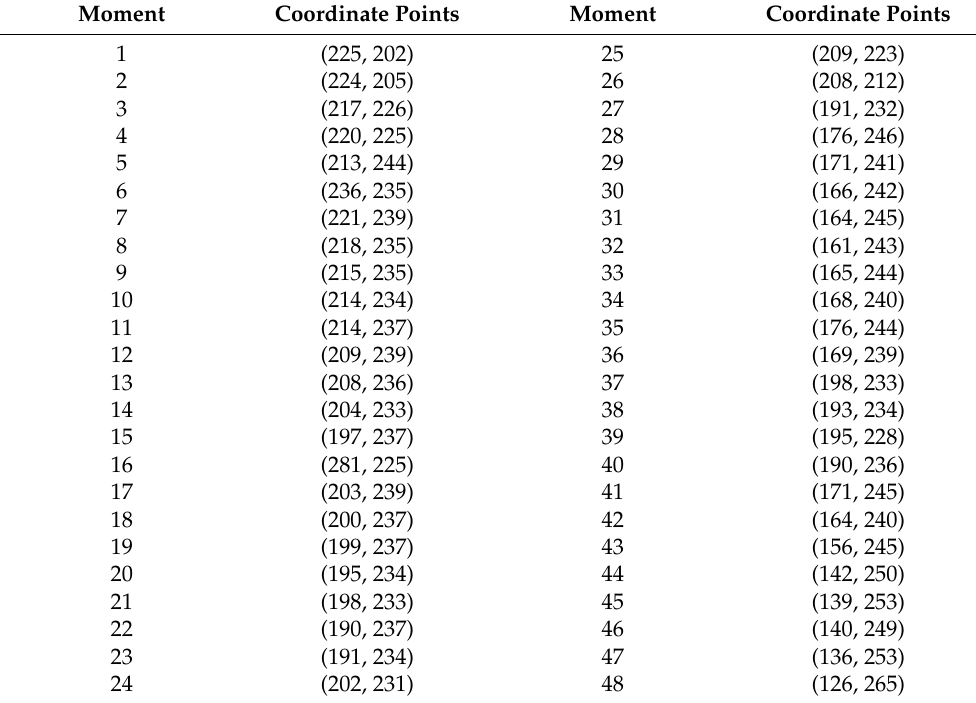
Table 1. Position of the center of mass at each moment during the melting of silicon dioxide in a hot